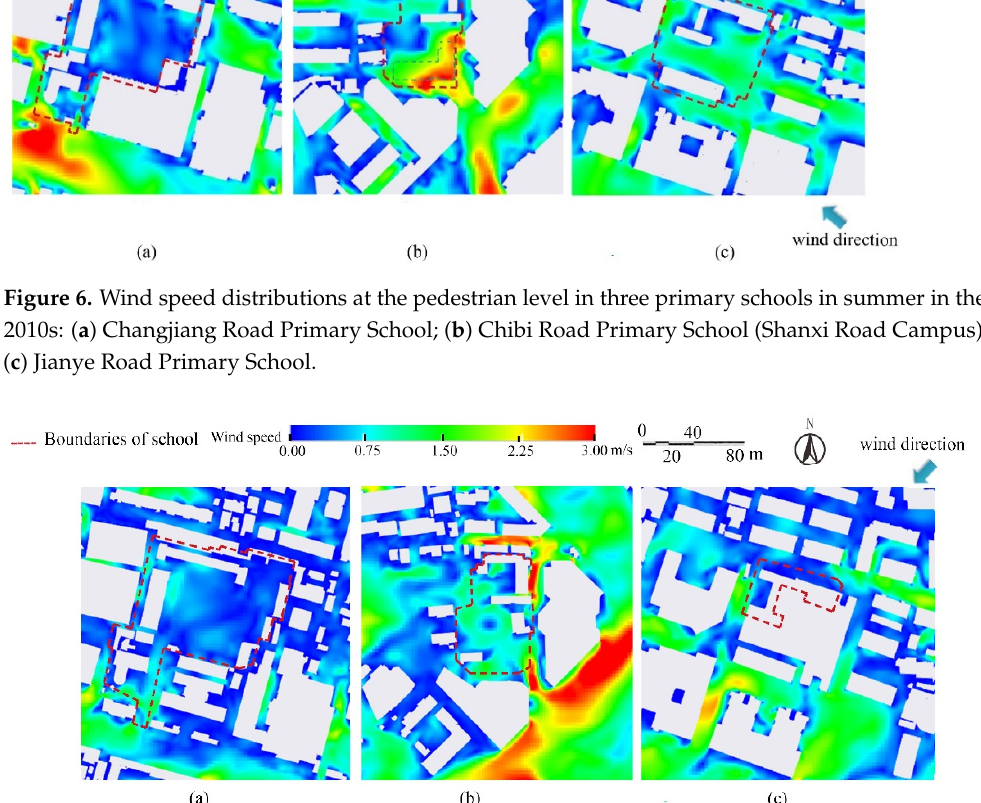
Figure 7. Wind speed distributions at the pedestrian level in three primary schools in winter in the 1990s: ( a ) Changjiang Road Primary School; ( b ) Chibi Road Primary School (Shanxi Road Campus); ( c ) Jianye Road Primary School.